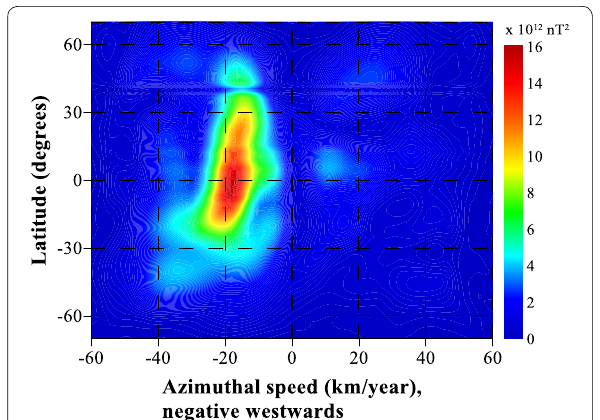
Fig. 6 Longitude-meridional-speed power plot of the core surface radial component of the sub-centennial constituent in case of North- ern Hemisphere (top) and Southern Hemisphere